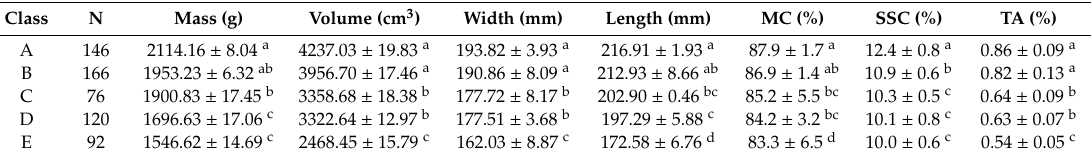
Figure 6. External characteristics of honey pomelo: ( A ) Samples of Class A; ( B) Samples of Class B; ( C ) Samples of Class C; ( D ) Samples of Class D; ( E ) Samples of Class E. Granulation levels of honey pomelo: ( a ) Samples of Class A; ( b ) Samples of Class B; ( c ) Samples of Class C; ( d ) Samples of Class D; ( e ) Samples of Class E. Table 1. Fruit characteristics, moisture content (MC), soluble solids content (SSC), and titratable acidity (TA) of honey pomelo for each granulation